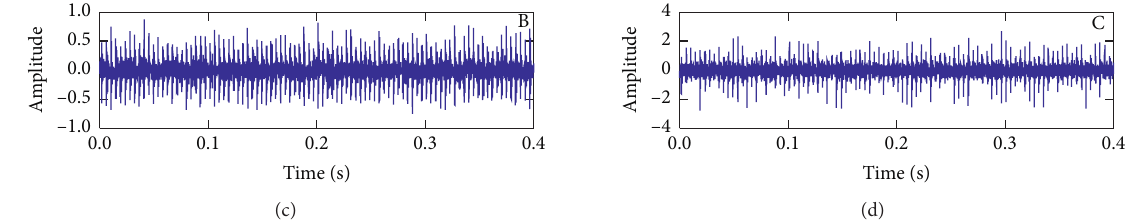
Figure 25: The test signal for experimental rolling bearing: (a) RMS for the whole life cycle; (b) early-stage vibration waveform of measuring point A; (c) mid-stage vibration waveform of measuring point B; (d) late-stage vibration waveform of measuring point C.